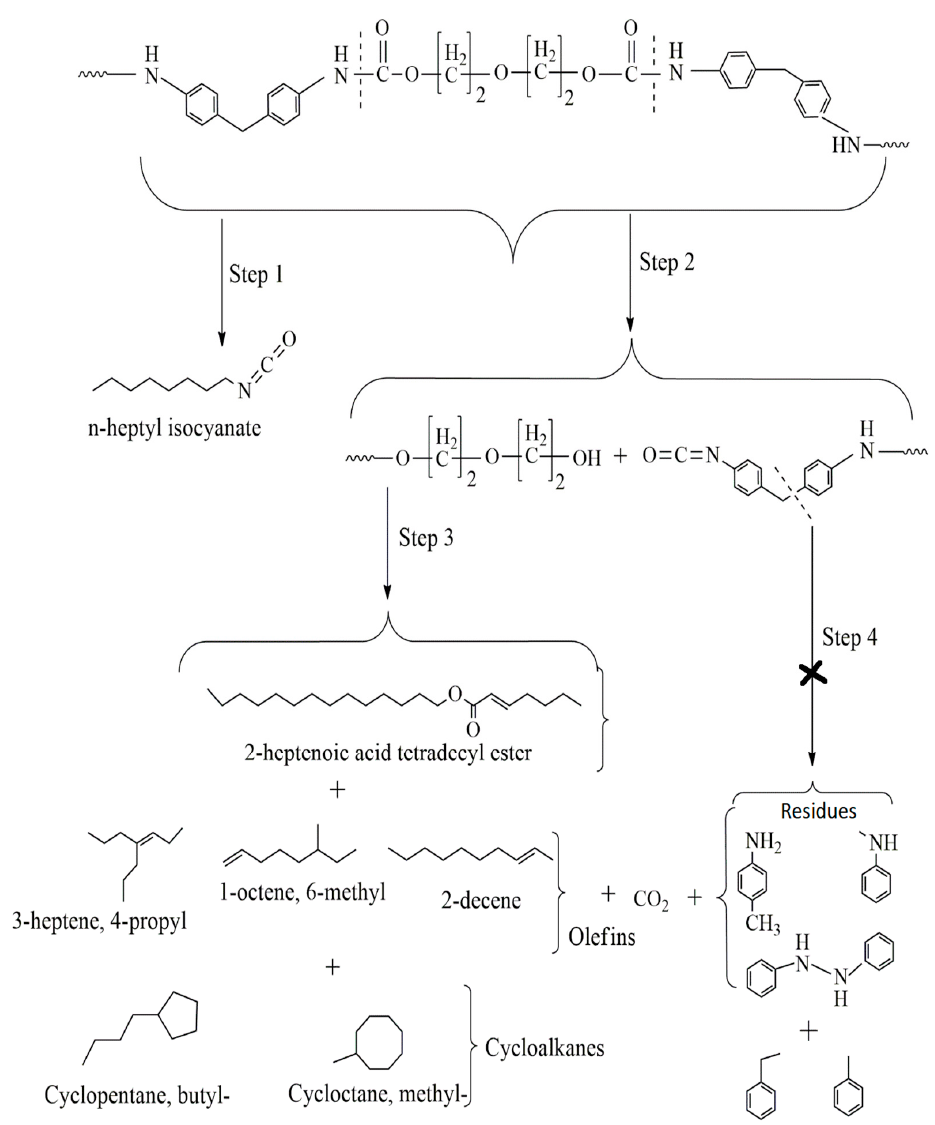
Figure 6. Reaction mechanism for the noncatalytic (Step 1) and catalytic (Step 2) pyrolysis of polyurethane present in industrial plastic waste 2 [52]. (Adapted with permission from Ref. [52], 2013, Elsevier) Table 6. Analysis of industrial plastic waste 2 by Py-GC/MS with and without sulfated zirconia catalyst.